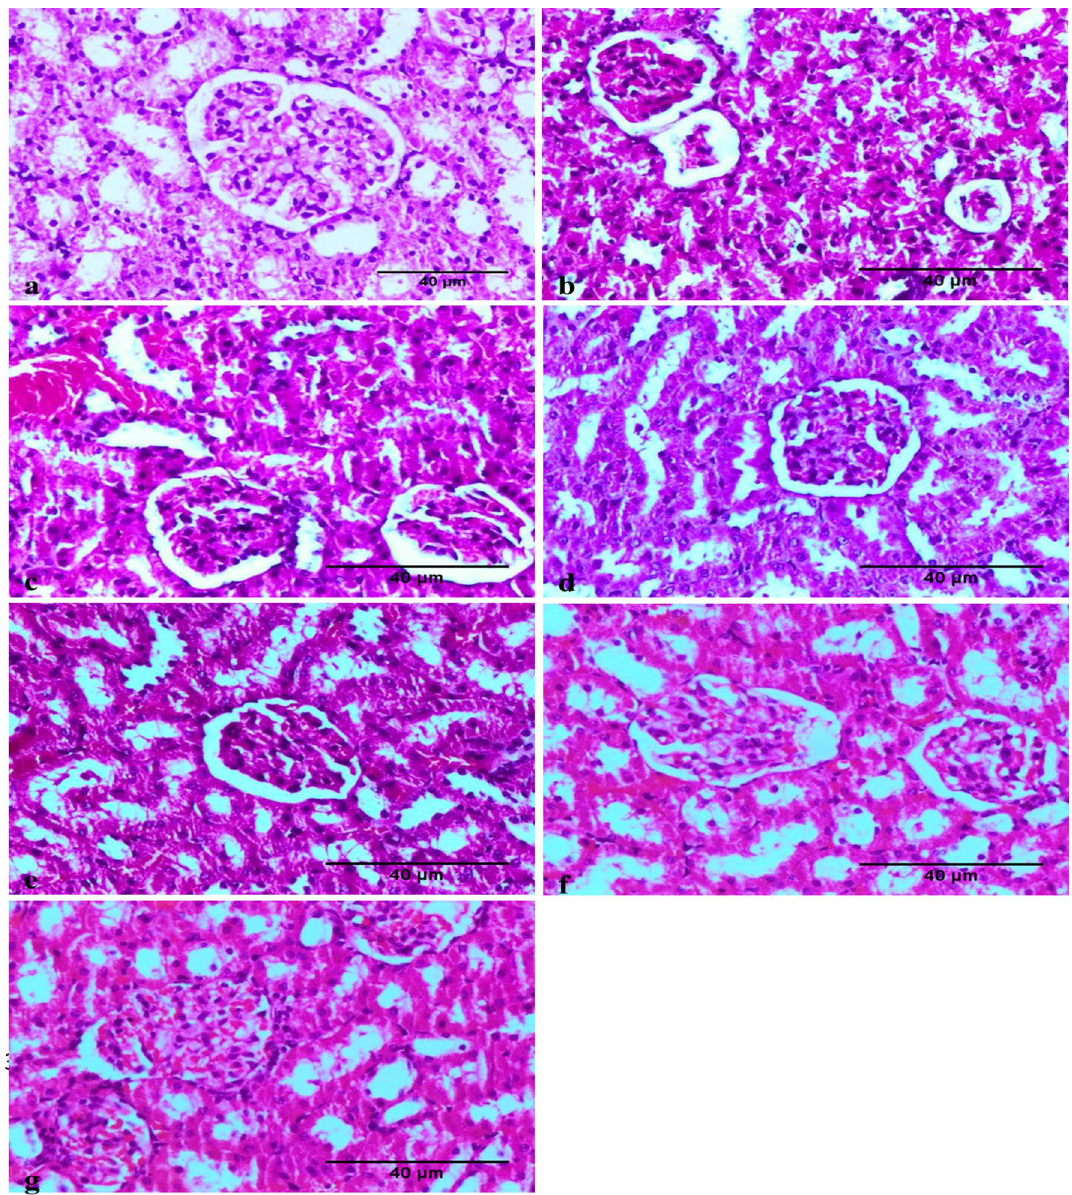
Figure 6. Photomicrograph showing the absence of histopathological changes in the kidney obtained from a rat in the negative control group ( a ). Section obtained from benzo[a]pyrene (B[a]P)-treated rats displaying severe necrosis and desquamation of renal tubular epithelial cells, atrophy, and degeneration of glomerular tuft with vacuolization in the Bowman’s space ( b ) and showing necrobiotic changes in the epithelial lining of the renal tubules, along with severe congestion ( c ). Images showing the apparent normal histologic features with mild individual cellular necrosis in groups exposed to zinc oxide nanoparticles (ZnO NPs) and B[a]P ( d and e ). Images showing the apparent normal histology with mild congestion and vacuolation of glomerular tuft in male rats treated with ZnO NPs (scale bar: 40 μm) ( f and g